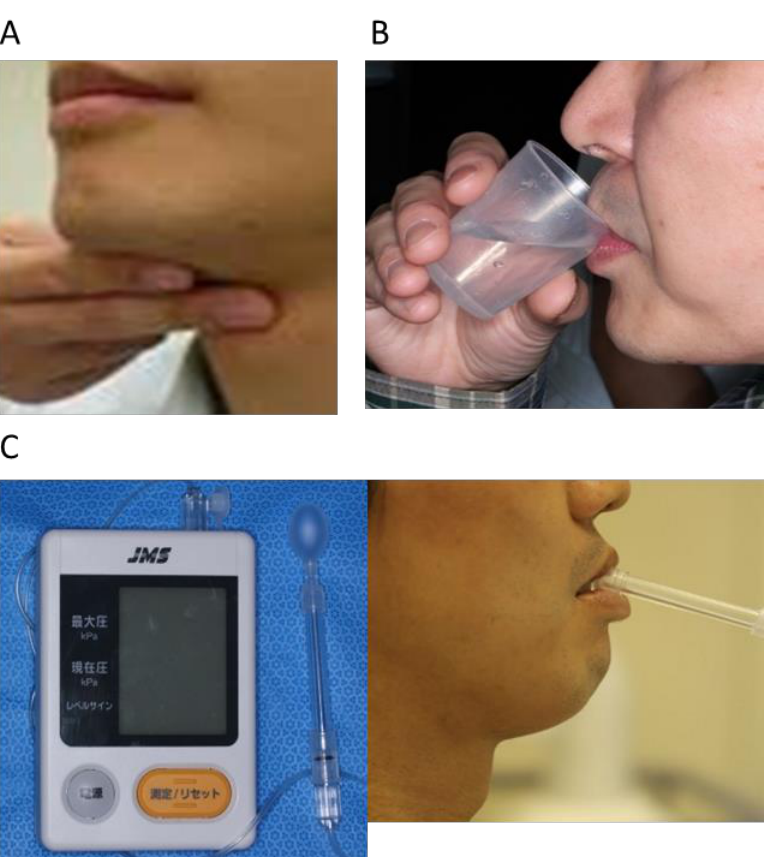
Figure 1. Assessments of dysphagia. ( A ) Repetitive swallow saliva test (RSST). Palpation of the laryngeal elevation with the index and middle fingers. ( B ) Water-swallowing test (WST). The patient was asked to drink 30 mL water as usual. ( C ) Tongue pressure: the patient was asked to raise their tongue and compress the balloon onto the palate with maximal voluntary effort for approximately 7 s.